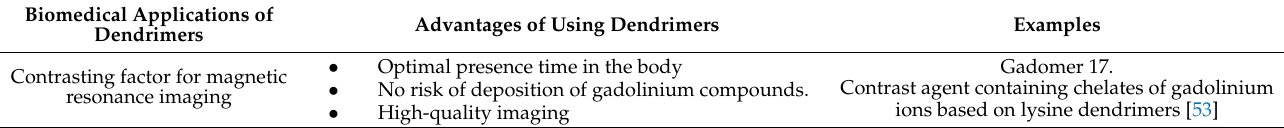
Table 1. Advantages and examples of dendrimer usage in